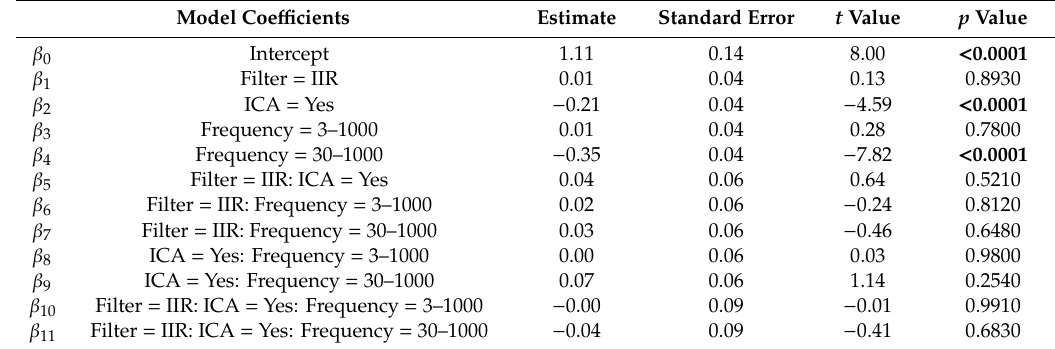
Table 3. Estimated N30 amplitude from the statistical model. Abbreviations: LCL = Lower Confidence Level; UCL = Upper Confidence